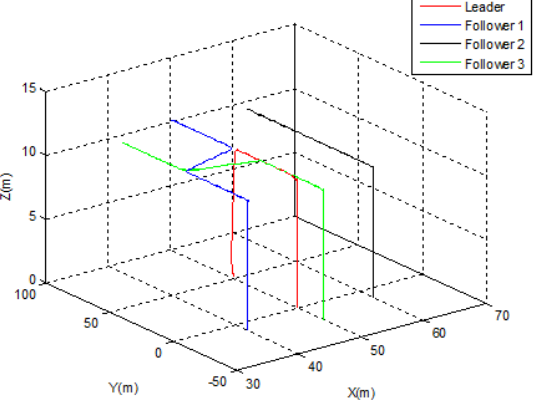
Figure 7. Leader election Case 1.